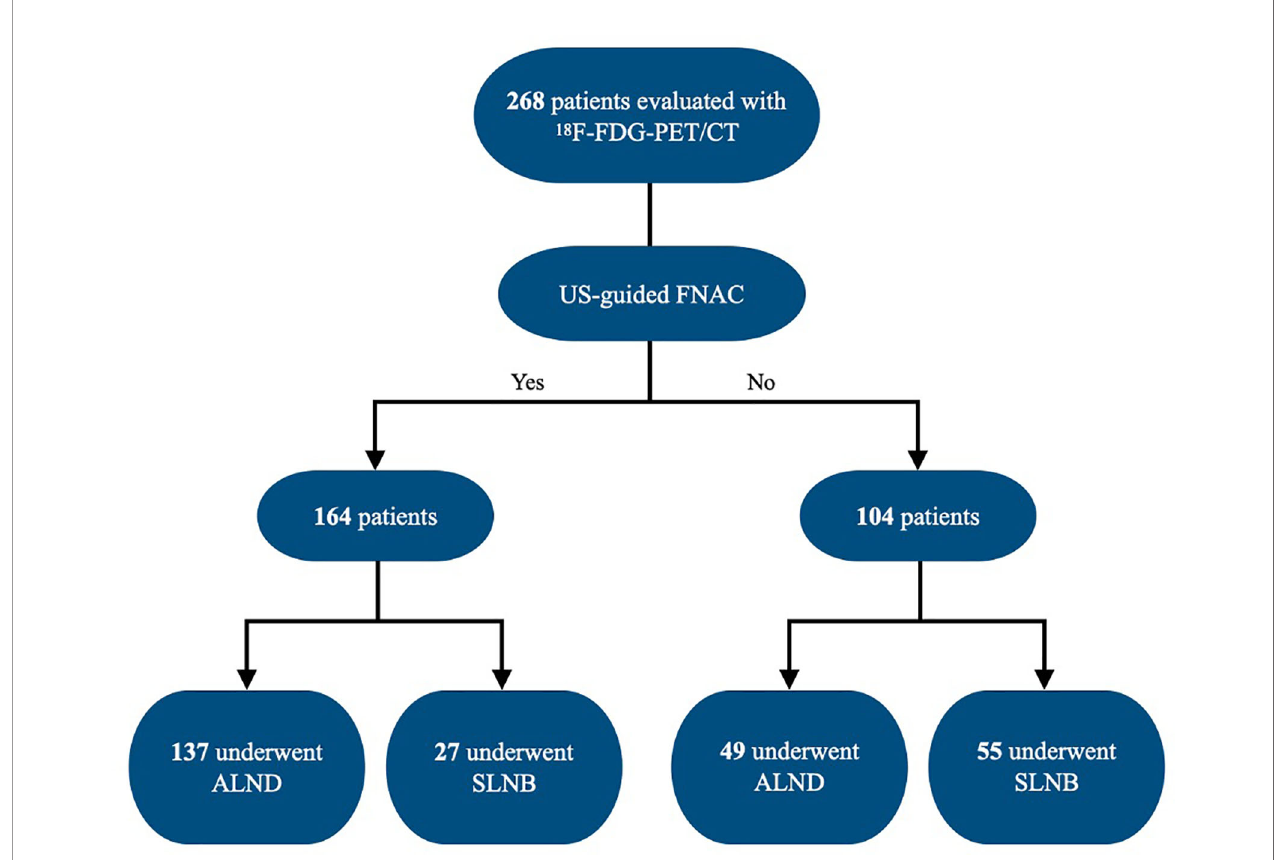
FIGURE 1 | Flowchart of the study group. FNA, fi ne-needle aspiration; ALND, axillary lymph node dissection; SLNB, sentinel lymph node